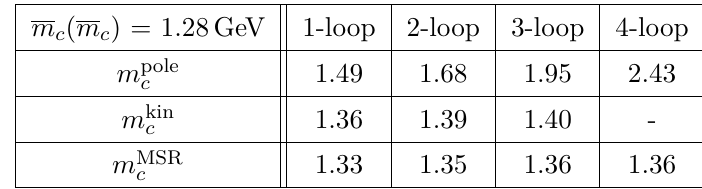
, defined in (2.44), is µ = 0 . 5 GeV for the kinetic mass, and f f